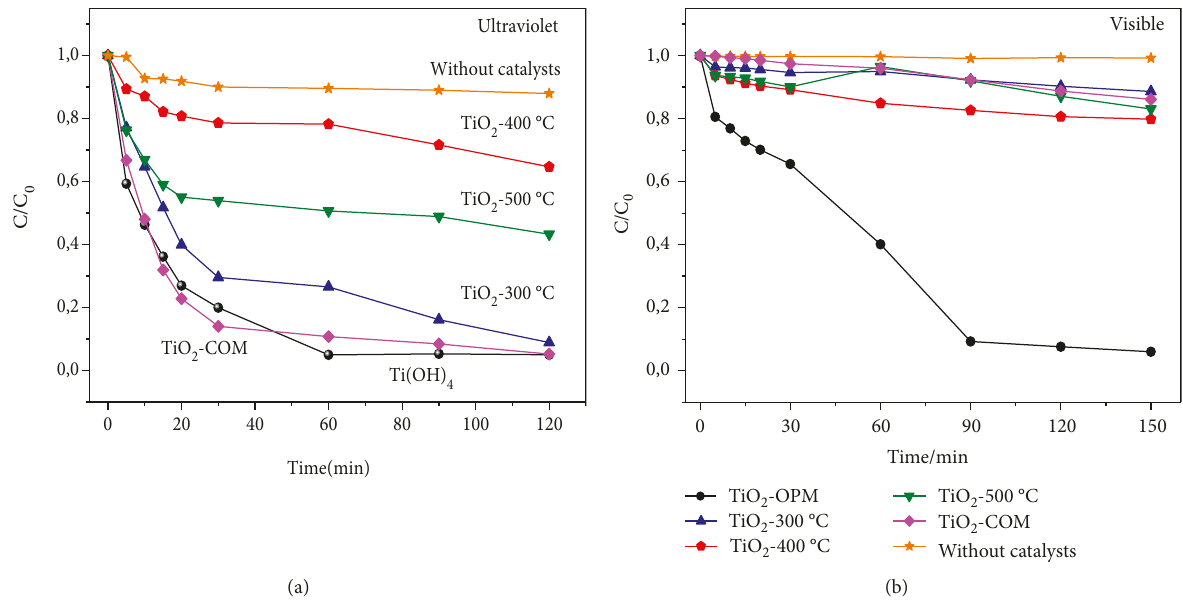
Figure 7: The kinetic process of MB degradation (a) under UV and (b) visible light radiation.